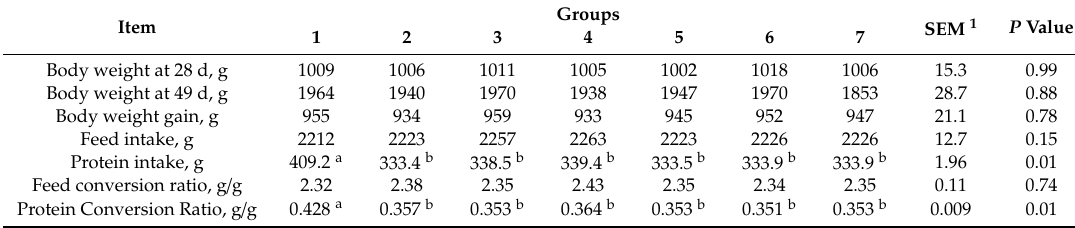
Table 2. Growth performance from 28 to 49 day of age (Trial 1).